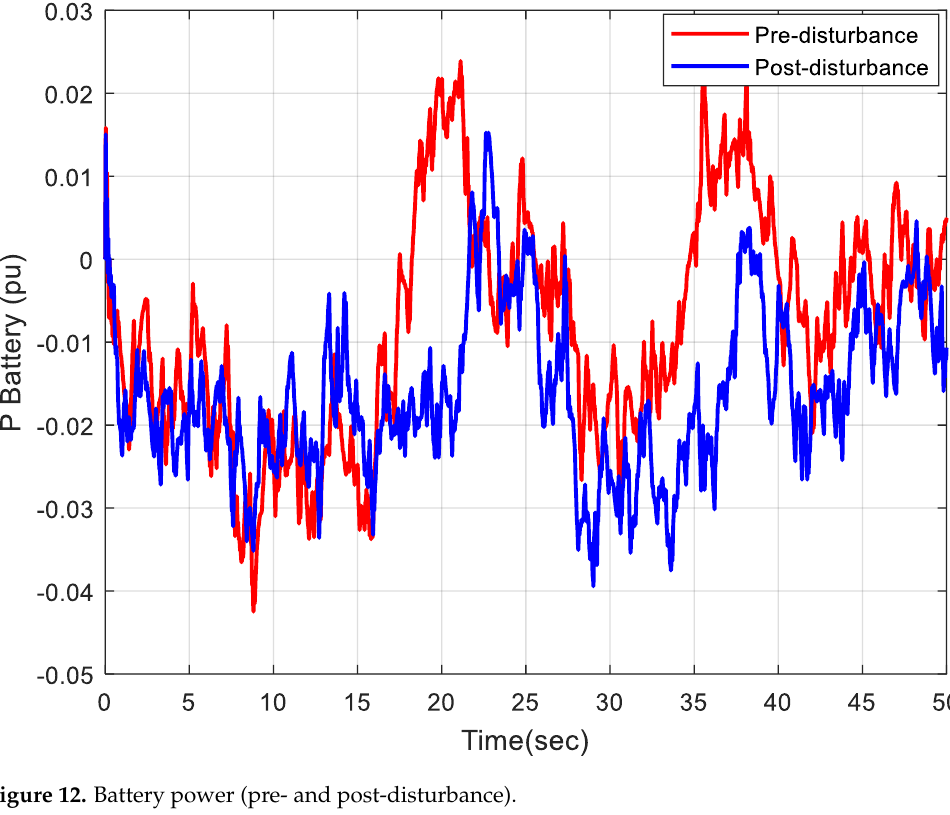
Figure 11. Photovoltaic power (pre- and post-disturbance).